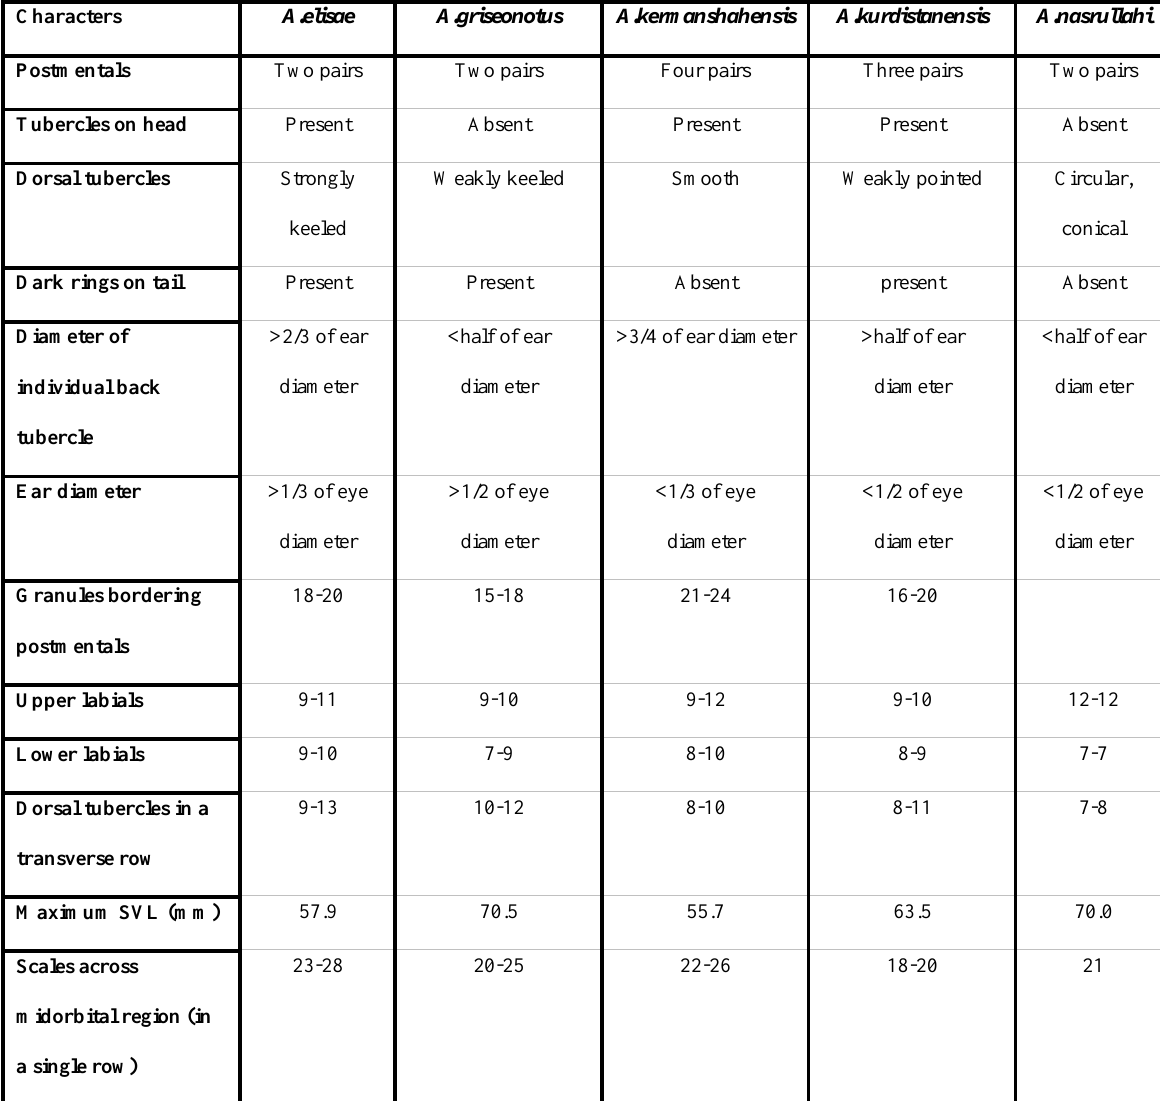
T ABLE 1 . The comparison of main morphological characters among different Asaccus species of